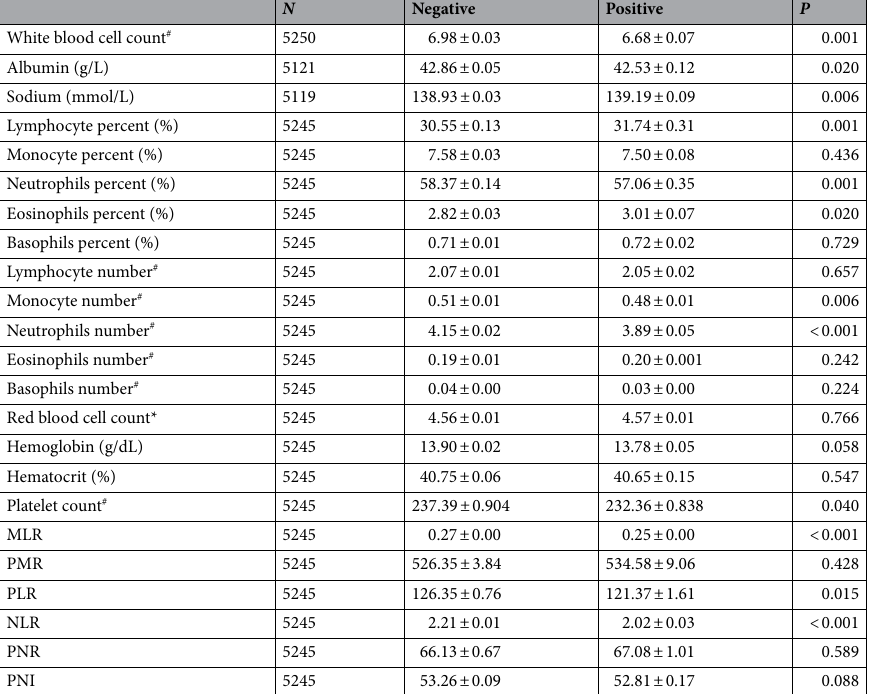
Table 2. The baseline characteristics of quantitative variables stratified by QFT-GIT results (means ± SE). BMI body mass index; MLR monocyte-to-lymphocyte ratio; PMR platelets-to-monocyte ratio; PMR platelets-to- monocyte ratio; PLR platelets-to-lymphocyte ratio; NLR neutrophil-to-lymphocyte ratio; PNR platelets-to- neutrophil ratio; PNI prognostic nutritional index ( PNI = Albumin + 5 × Lymphocyte number). The unit for variables with a pound sign (#) was 1000 cells/uL, and for variables with an asterisk (*) was million cells/uL.